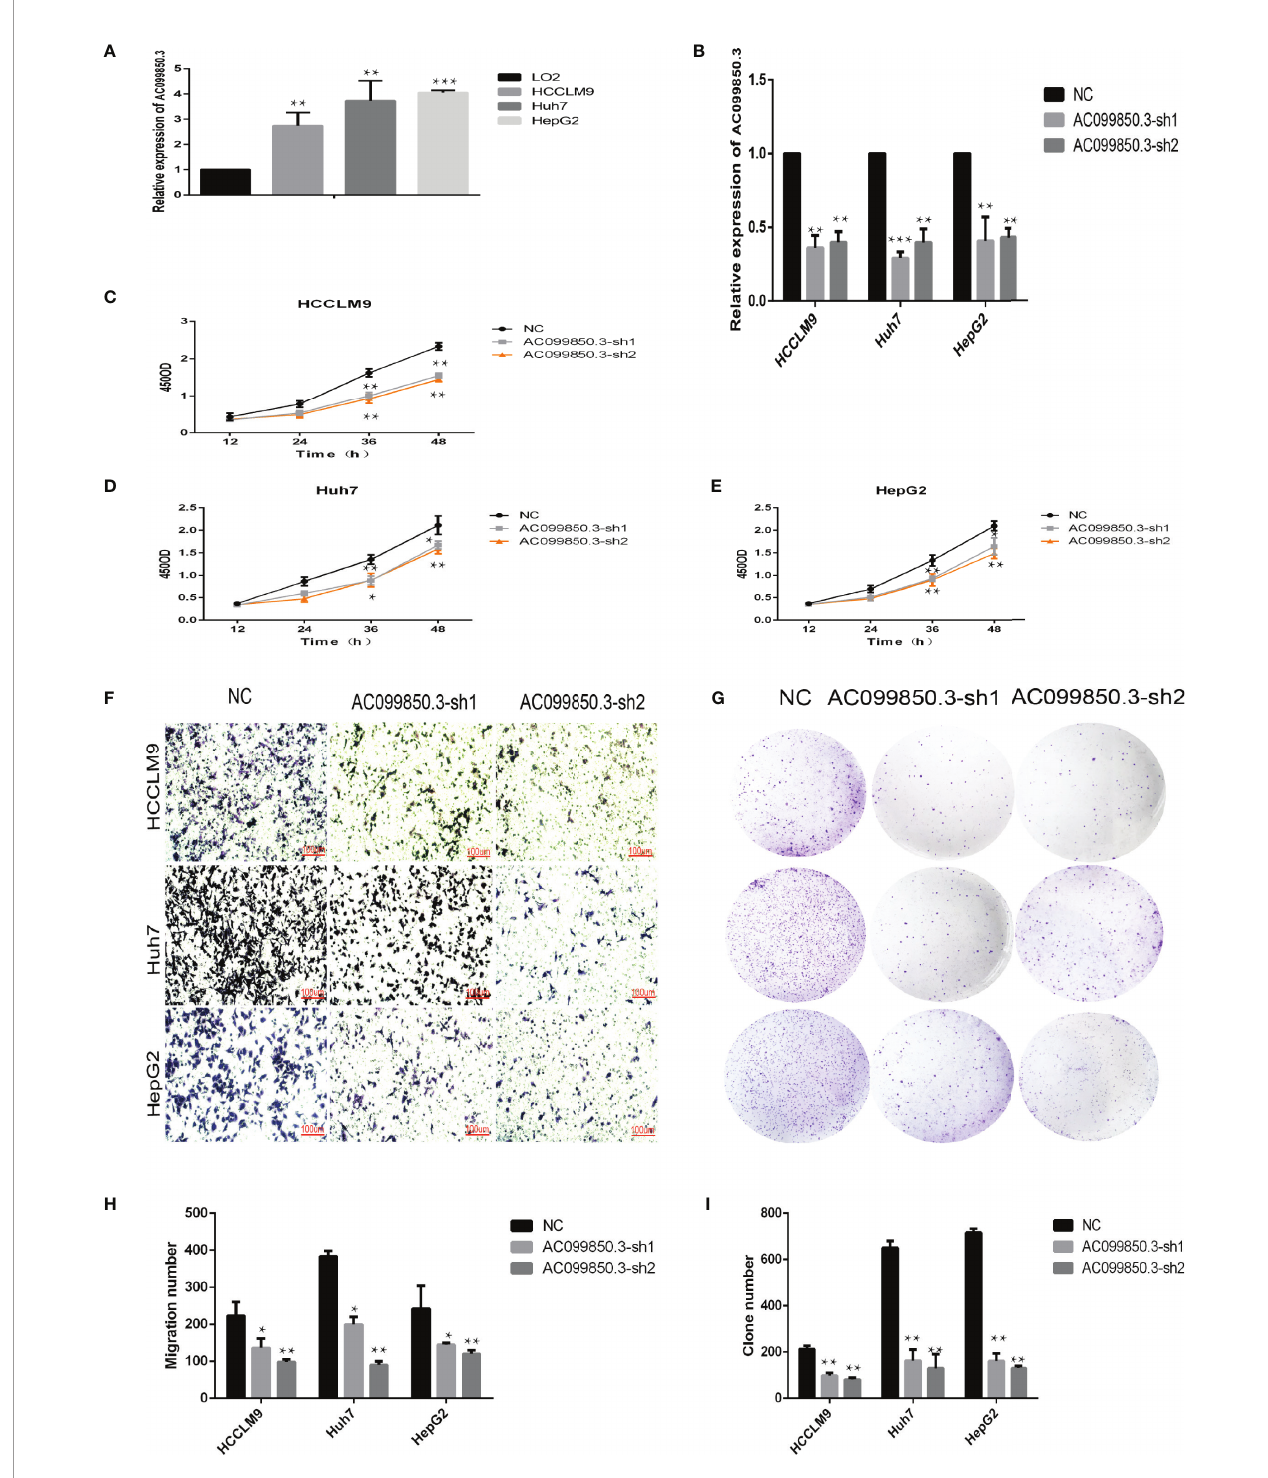
FIGURE 9 | LncRNA AC099850.3 promoted the proliferation and migration of HCC cells. (A) The expression of AC099850.3 in HCCLM9, Huh7, and HepG2 cells was signi fi cantly higher than that in normal LO2 cells. (B) Veri fi cation of the AC099850.3 interference ef fi ciency of the HCC cell line at the mRNA level. (C – E) The CCK-8 assay showed that the HCC cell activity in the interference groups was lower than that in the control groups. (F) Transwell analysis showed that cell migration was signi fi cantly inhibited in the interference groups. (G) Colony formation analysis showed that the proliferation rate of cells in the interference groups was signi fi cantly inhibited. (H, I) The histograms of the Transwell and the Colony formation analysis, respectively. (*P < 0.05, **P < 0.01, ***P <